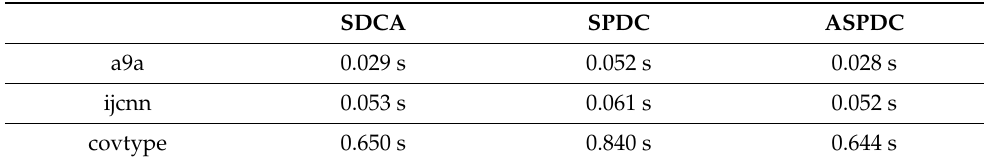
Table 4. The average running time for the algorithms to pass through the entire dataset once when λ = 0.01.